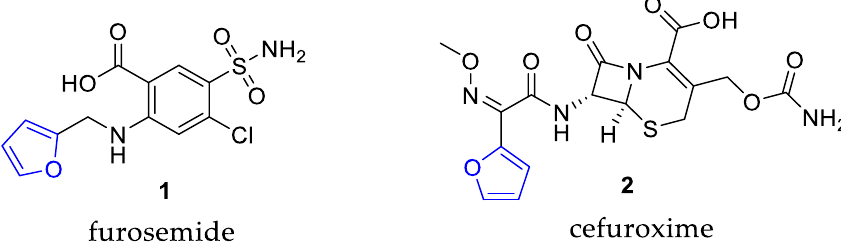
Figure 1. Biologically active compounds of the furan